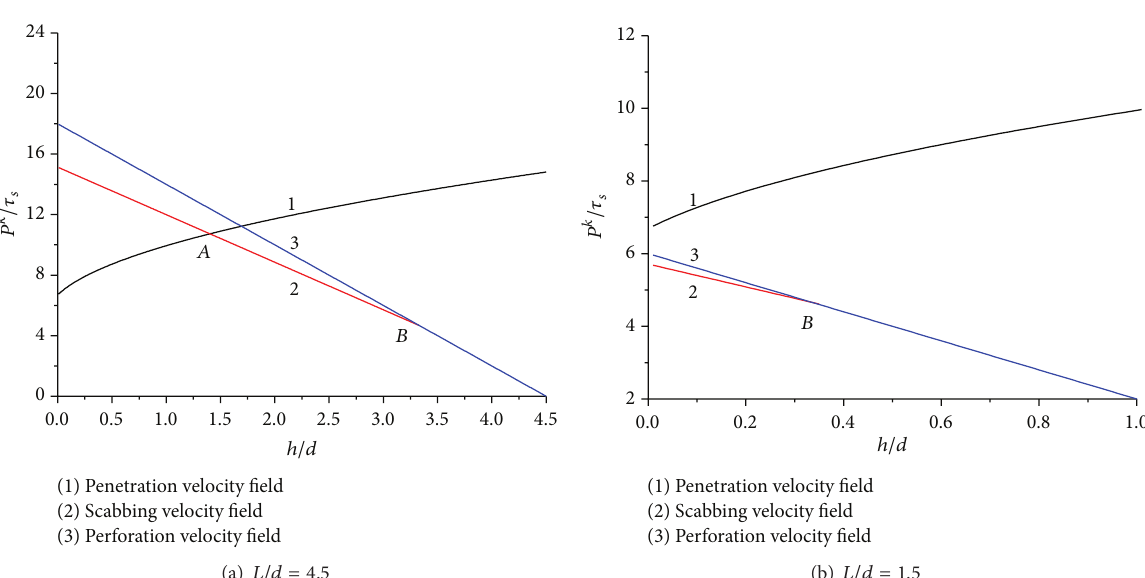
Figure 5: The resistance curves of concrete target impacted by flat-nosed